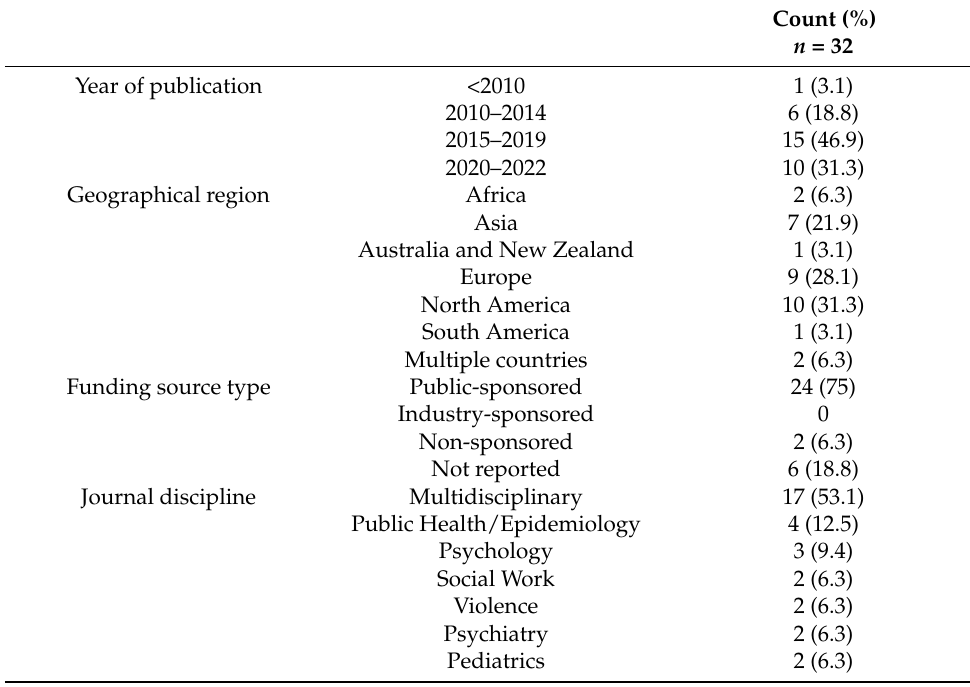
Table 2. Document